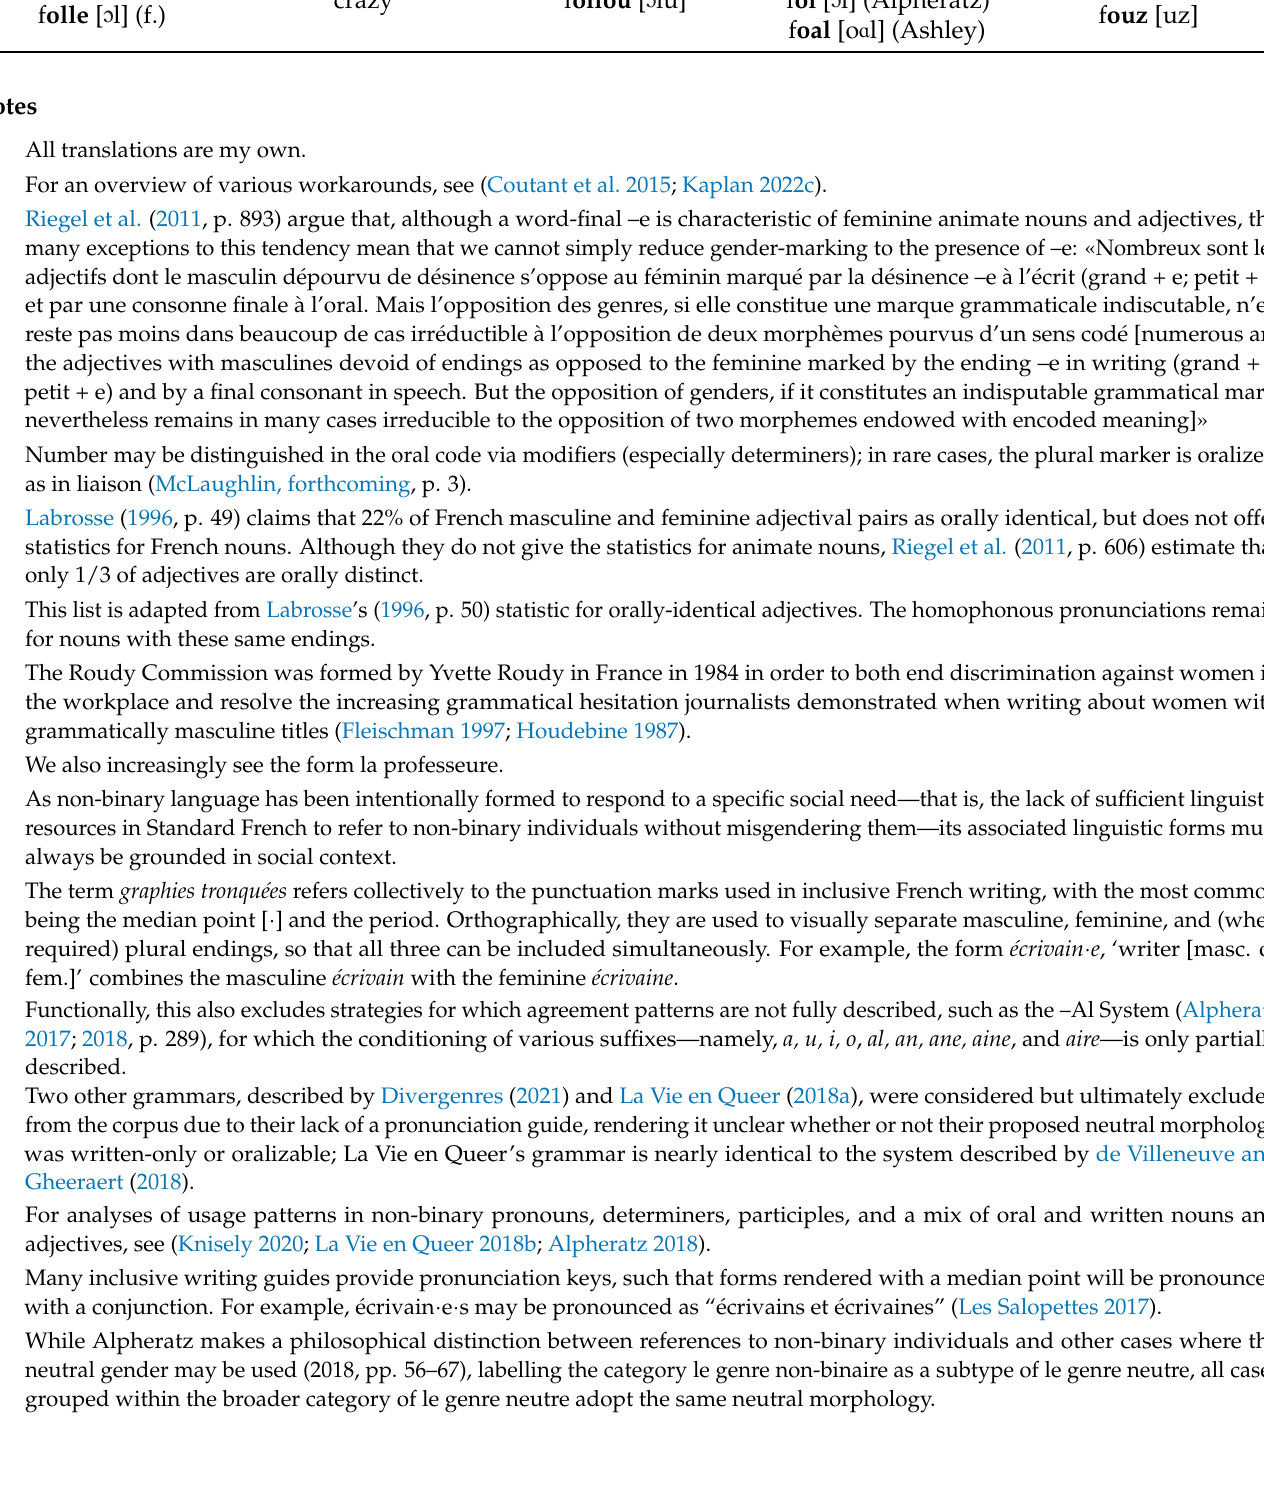
Table 2. Masculine and Feminine Homophones.